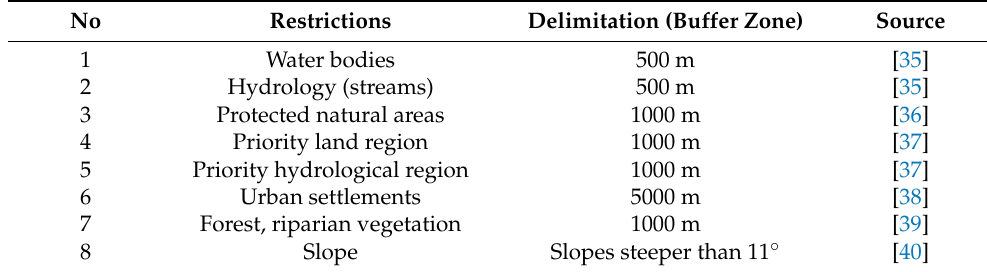
Table 1. Restrictions influencing site-suitability for the development of solar farms.